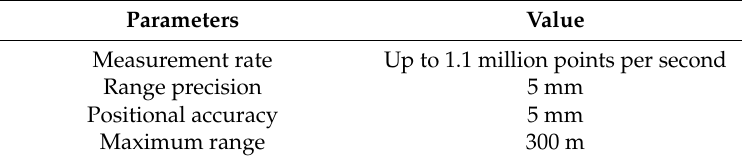
Figure 6. RIEGL VMX-450 mobile laser system. Table 4. Specifications of RIEGL VMX-450 used to collect data in this research.